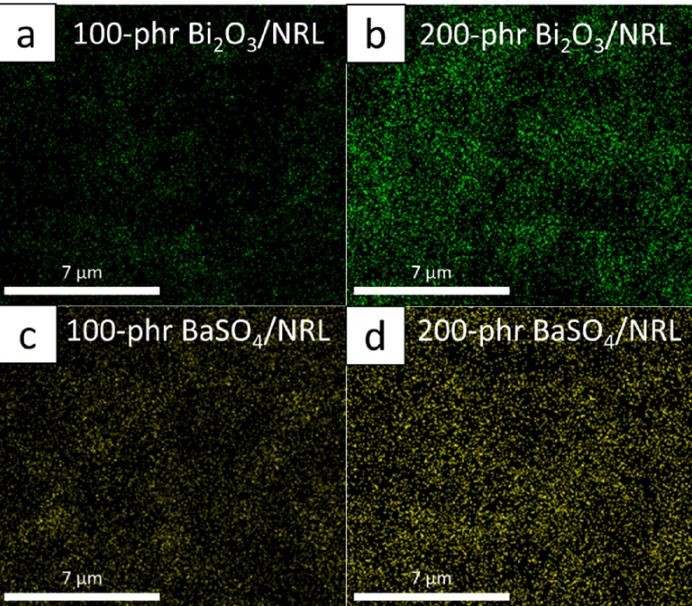
Figure 4. Dispersion of ( a , b ) Bi and ( c , d ) Ba elements in ( a ) 100 phr Bi 2 O 3 /SVNRL, ( b ) 200 phr Bi 2 O 3 /SVNRL, ( c ) 100 phr BaSO 4 /SVNRL, and ( d ) 200 phr BaSO 4 /SVNRL composites. The images were taken using SEM-EDX with 10,000× magnification.